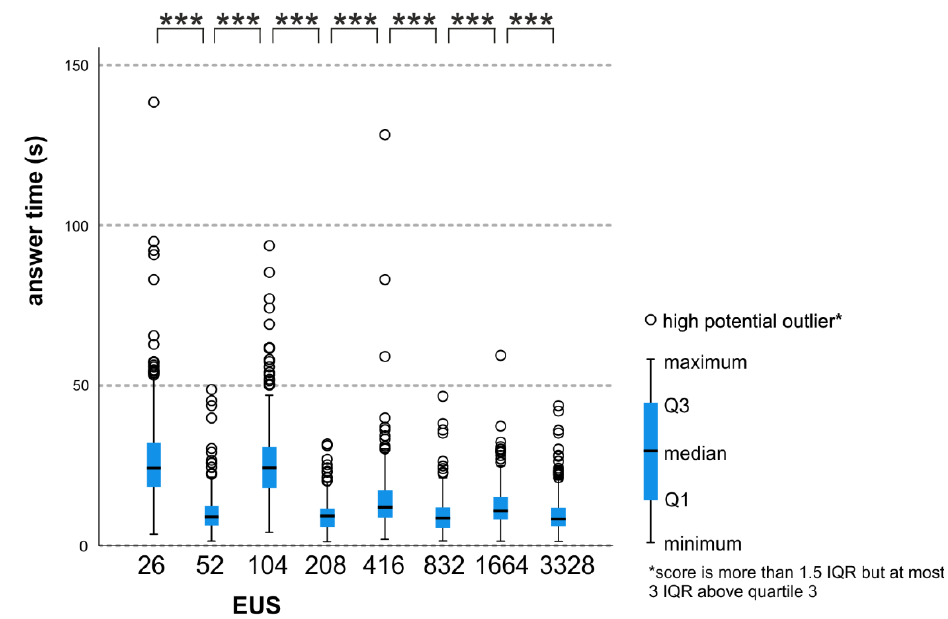
Figure 13. Participants’ answer times pairwise comparison concerning T7: Correct and incorrect spatial patterns of the particular enumeration unit sizes, *** p ≤ 0.001.